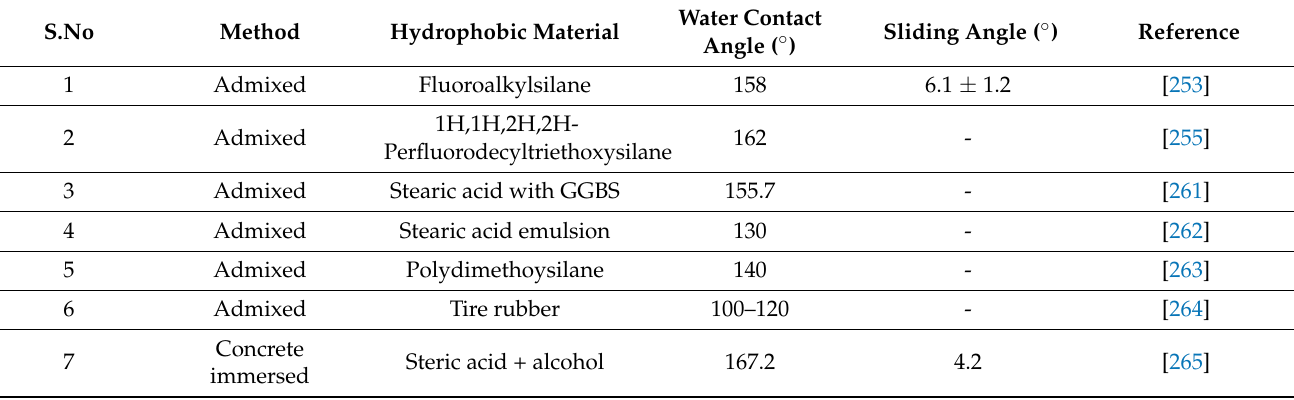
Table 8. Superhydrophobic additives admixed in